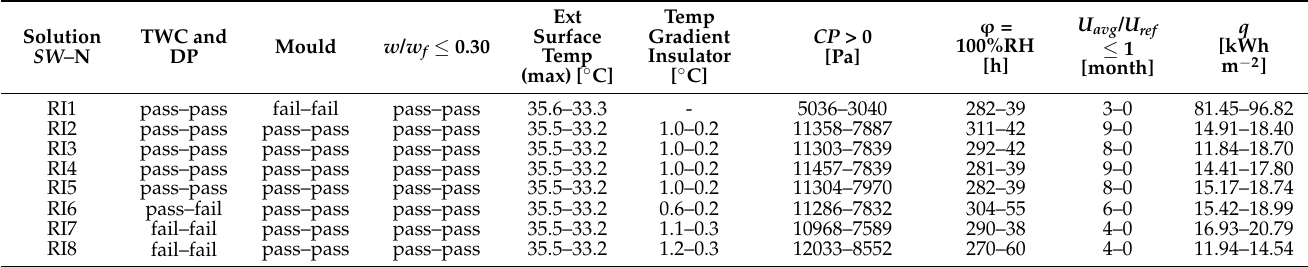
Table 9. Synthesis of the interior retrofit simulation for Lisbon